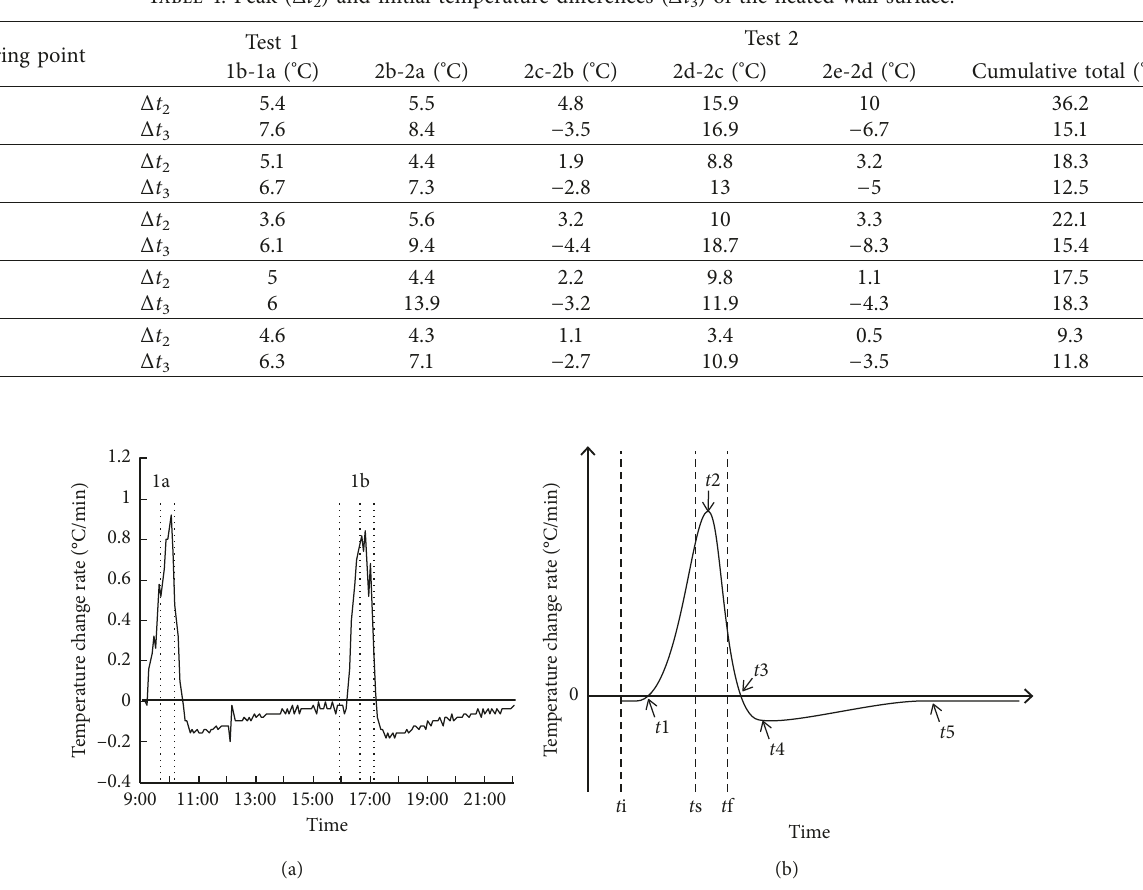
Figure 10: (a) Test 1 temperature change rate at point F on the heated wall; (b) time node diagram of the temperature change rate of the heated wall (measuring point